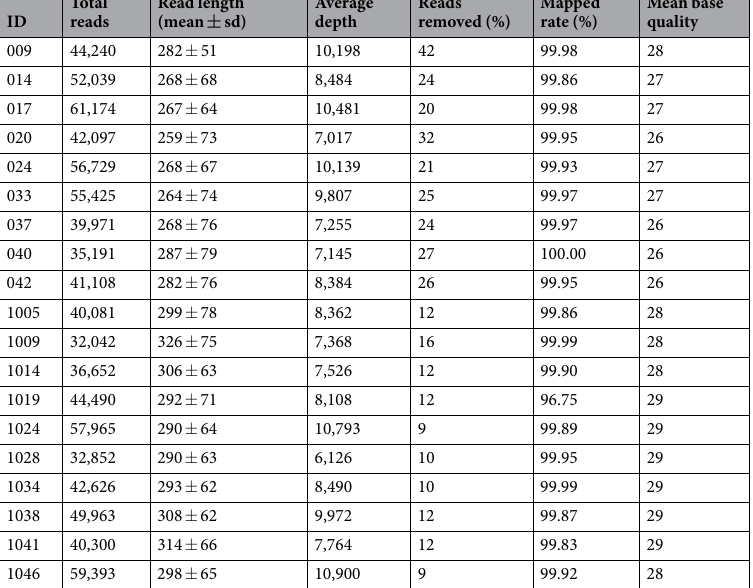
Table 2. Summary of the Ion Torrent PGM data for the HBV RT region.